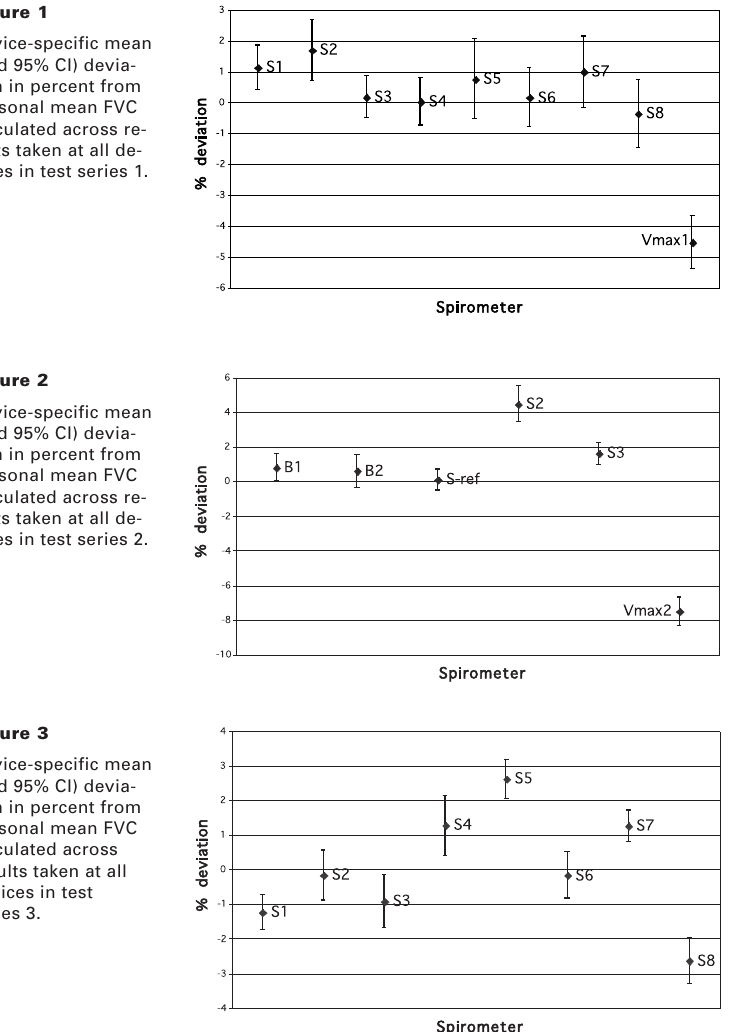
Device-specific mean (and 95% CI) devia- tion in percent from personal mean FVC calculated across re- sults taken at all de- vices in test series 1.